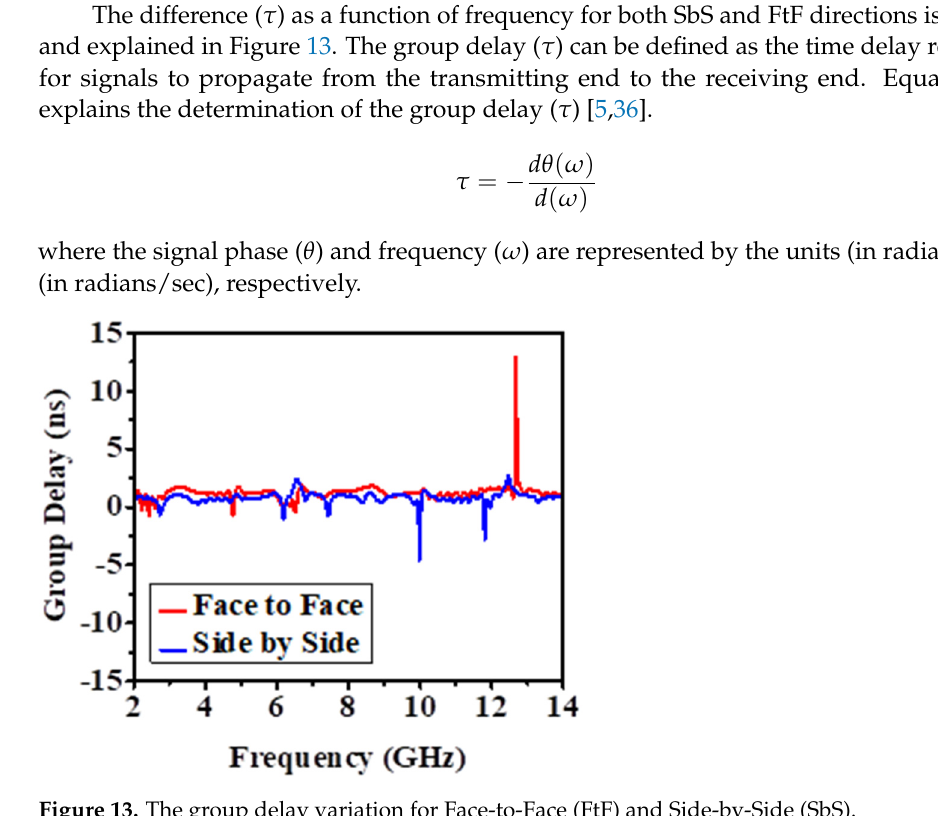
Figure 13. The group delay variation for Face-to-Face (FtF) and Side-by-Side